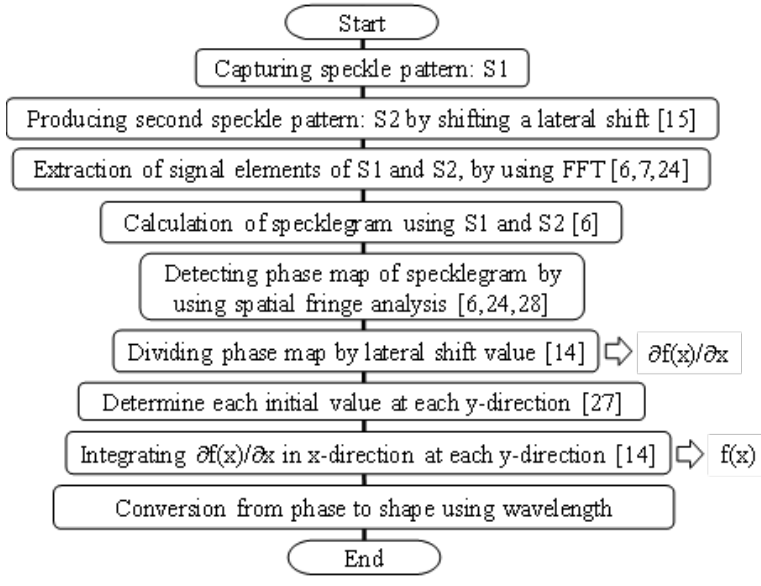
Figure 6. Flowchart of processing in Figures 5 and 7.